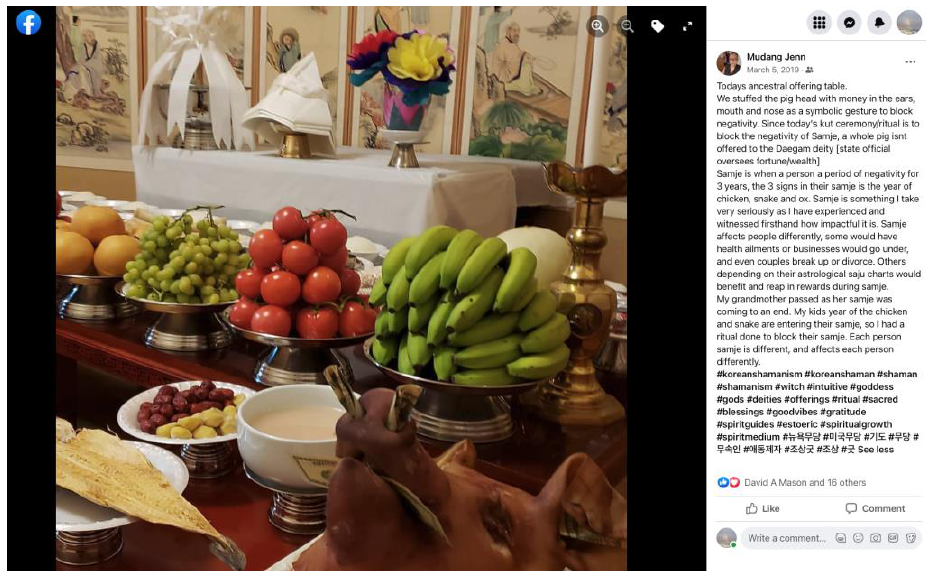
Figure 8. Altar for the ancestors. Screen capture from Mudang Jenn’s Facebook page. March 2019, the photograph is published with authorization from Jennifer Kim.